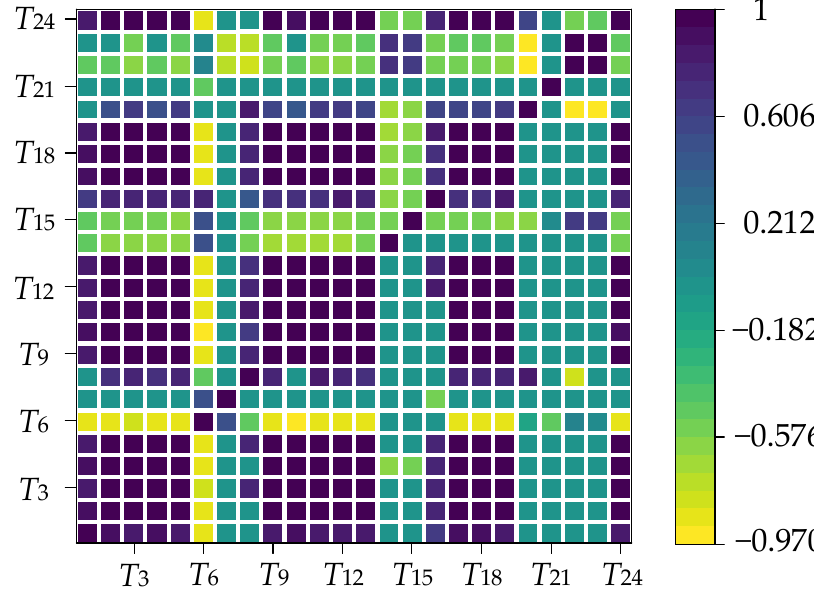
Figure 6. PCC between features.